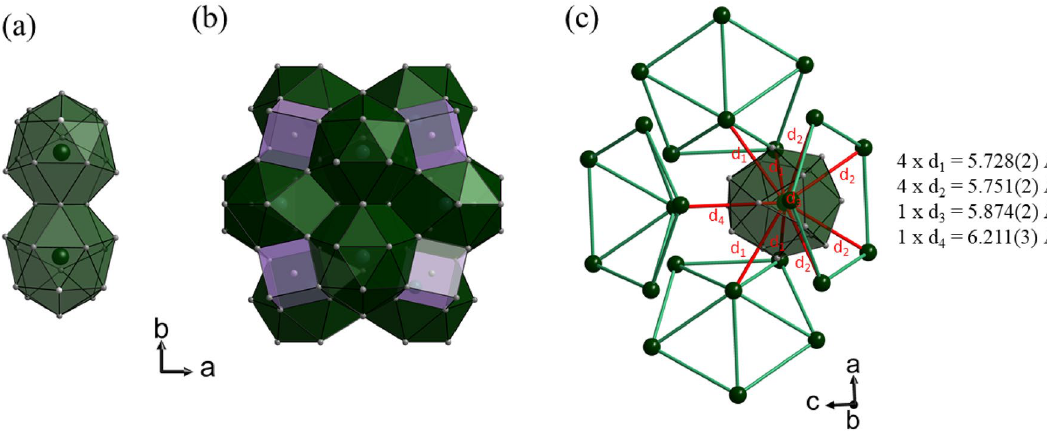
Figure 8. Crystal structure of the 1/1 AC. ( a ) Pair of Gd(Au/Al) 16 polyhedra condensed via a common triangle, ( b ) arrangement of Gd(Au/Al) 16 polyhedra and AlAu 8 cubes in the unit cell and ( c ) Gd partial structure. Nearest Gd–Gd interatomic distances are drawn as red lines and their numbers are listed. The green lines highlight the connectivity of Gd atoms into icosahedral shells in Tsai